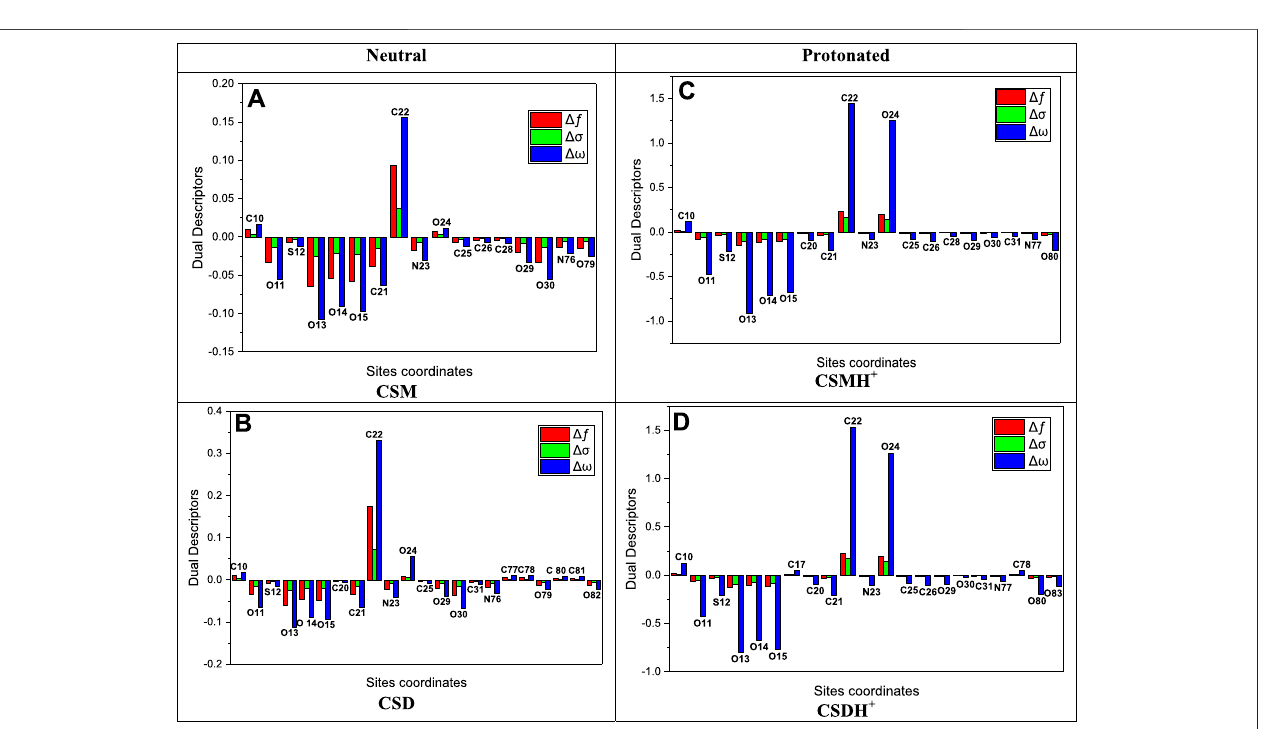
FIGURE10| Graphicalrepresentationofthedualdescriptors( Δ f , Δ σ ,and Δ ω )forthemostactivesitesoftheinvestigatedCSMandCSDsurfactantsinneutral (A,B) and protonated (C,D) forms using the DFT